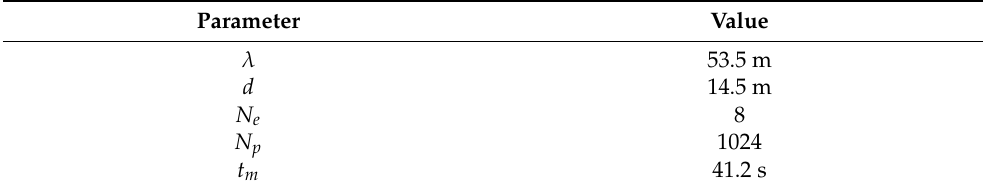
Table 3. System parameters of measured data.